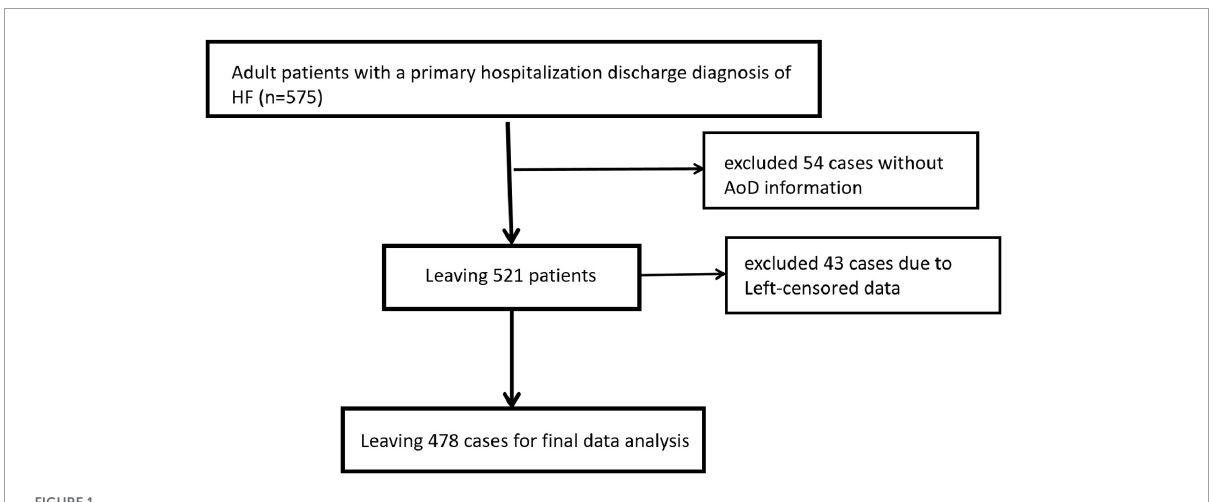
FIGURE1 The flowchart of patients selection.